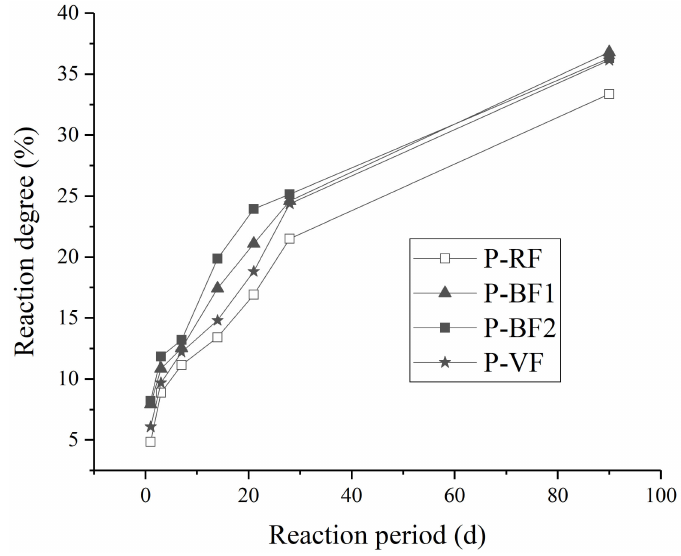
Figure 7. Reaction degree in different curing